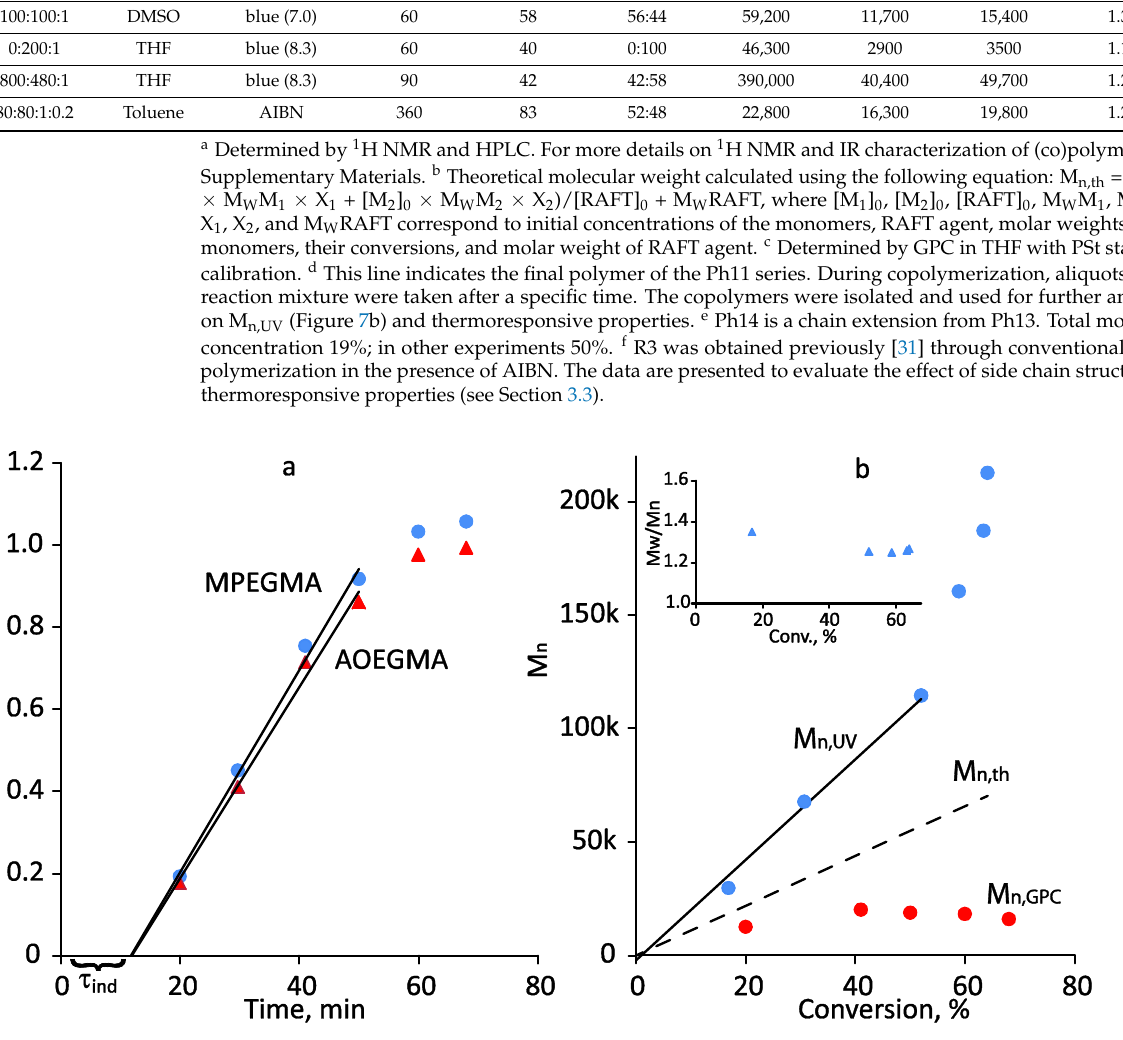
Figure 7. Kinetic first-order plot ( a ), and the plot of M n,UV , M n,th , M n,GPC and M W /M n vs. conversion ( b ) for the photo-induced RAFT copolymerization of MPEGMA and AOEGMA in toluene (Ph11). Polymerization conditions: ω MPEGMA = 50 wt.%, [MPEGMA] 0 /[AOEGMA] 0 /[CDTPA] 0 = 100:100:1, blue LED, 8.3 mW/cm 2 , 35 °C.